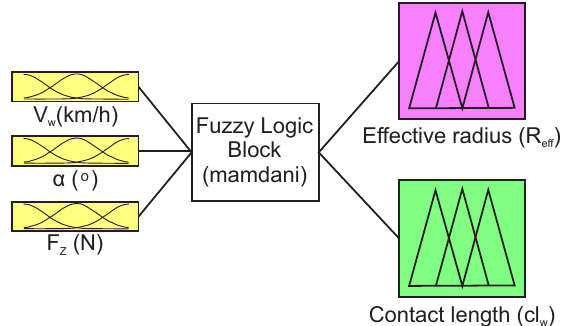
Figure 16. Estimator architecture developed through fuzzy